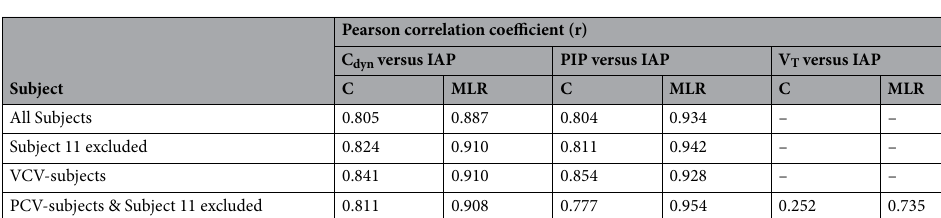
Figure 4. IAP, airway pressure, respiratory flow, and volume of PCV-patient (Subject 12). (A) PIP reached P ins , max , and increasing IAP, therefore, caused a drop in the inspirational tidal volume. (B) PIP could not reach P ins , max , and changes in IAP, therefore, affected PIP . ( a ) Zoom in of airway pressure, ( b ) Extracted PIP , a trend component, and detrended PIP .